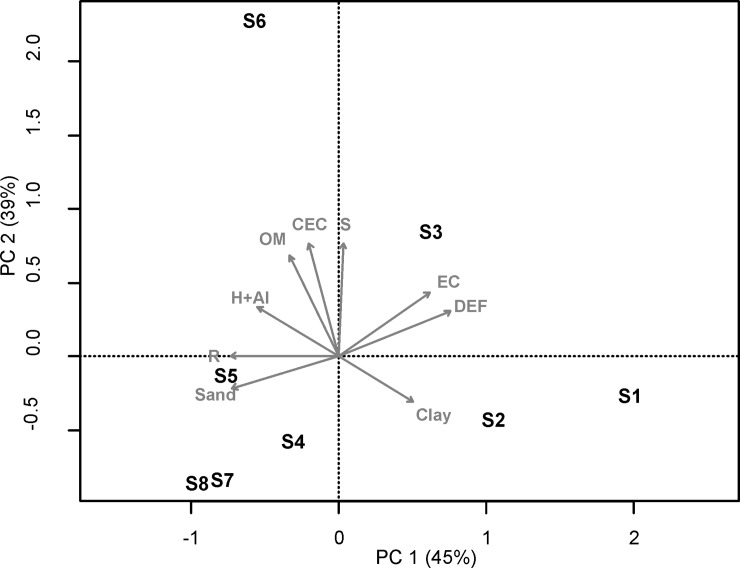
PCA biplot diagram ordering the subset of eight sites according to stress gradient.Site codes are presented in Table 1.